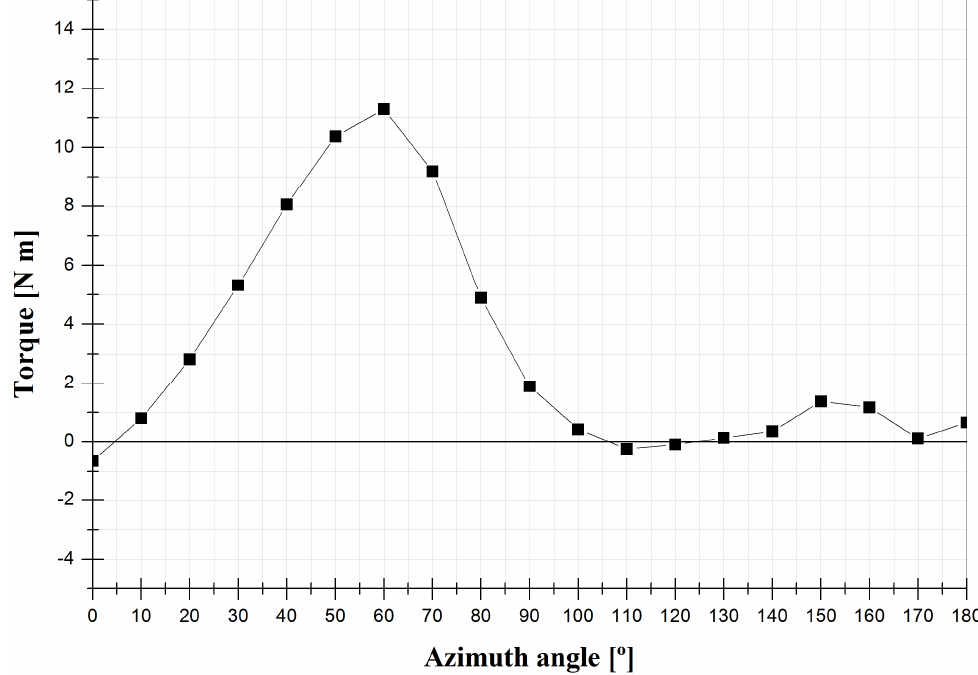
Figure 8. Torque variation of a blade for revolution.